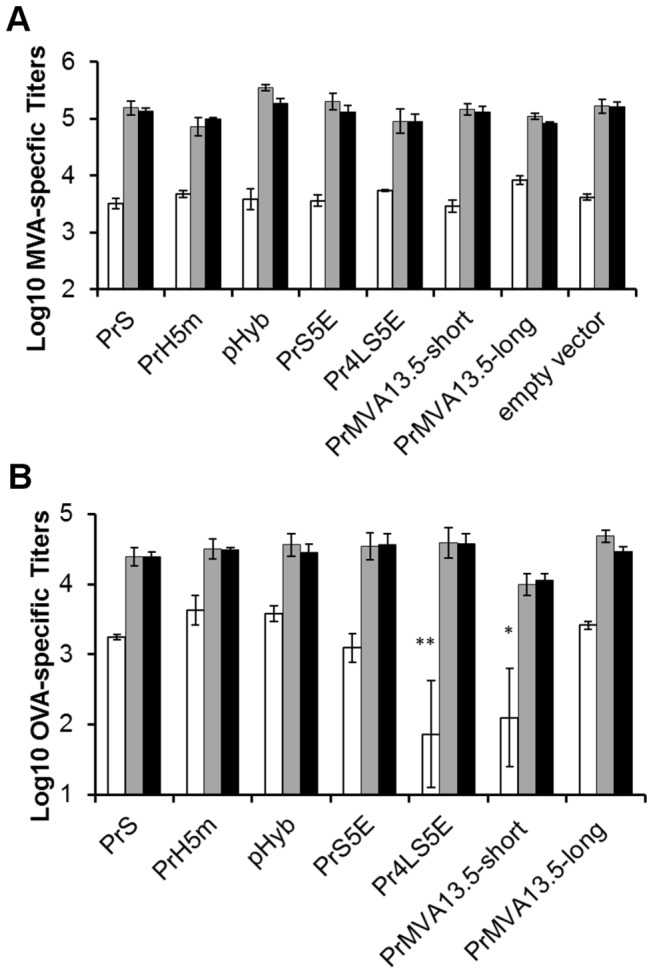
OVA and vector specific antibody titers.Antibody titers specific for MVA (A) or OVA (B) were determined three weeks after the first (white bars), second (gray bars) and third (black bars) immunization (immun). Individual endpoint titers were obtained for each mouse and the respective log10 transformed values were calculated. The values reported are the average log10 transformed titers for each group +/- SEM values. *, indicates values with significant differences (p > 0.05) compared to PrS, PrH5m, pHyb, and PrMVA13.5-long. **, indicates values with significant differences (p < 0.05) compared to PrS, PrH5m, pHyb, PrS5E and PrMVA13.5-long.